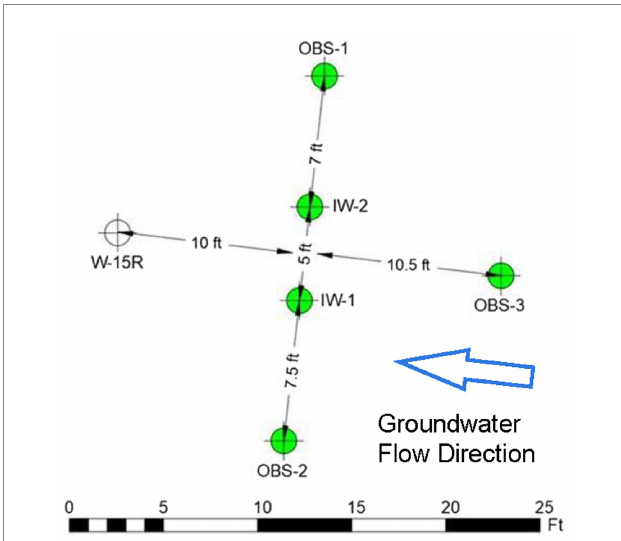
FIGURE 9 Site 2 field pilot study layout. IW-1 and IW-2 are injection wells. OBS-3 monitors conditions upgradient of the injection area. OBS-1 and OBS-2 monitor conditions cross-gradient to the injection area. W-15R monitors conditions downgradient of the injection